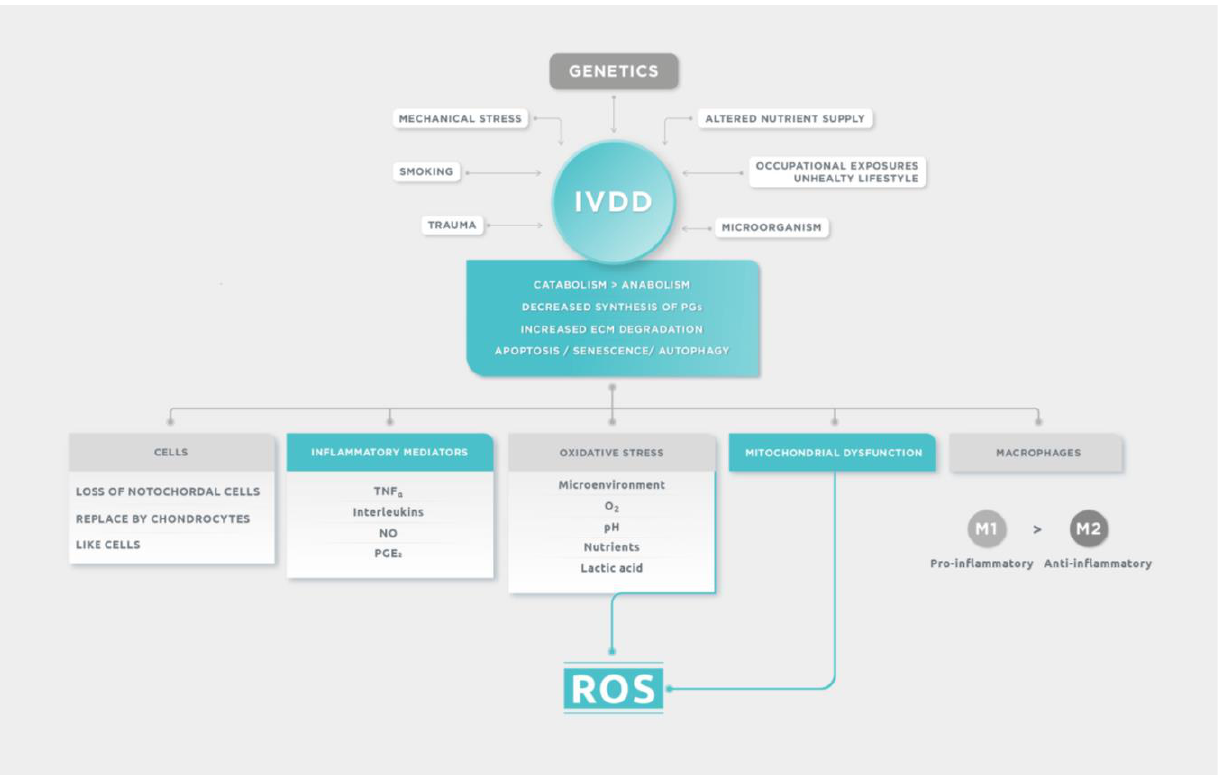
Figure 1. Etiology and main degenerative events in IVDD.